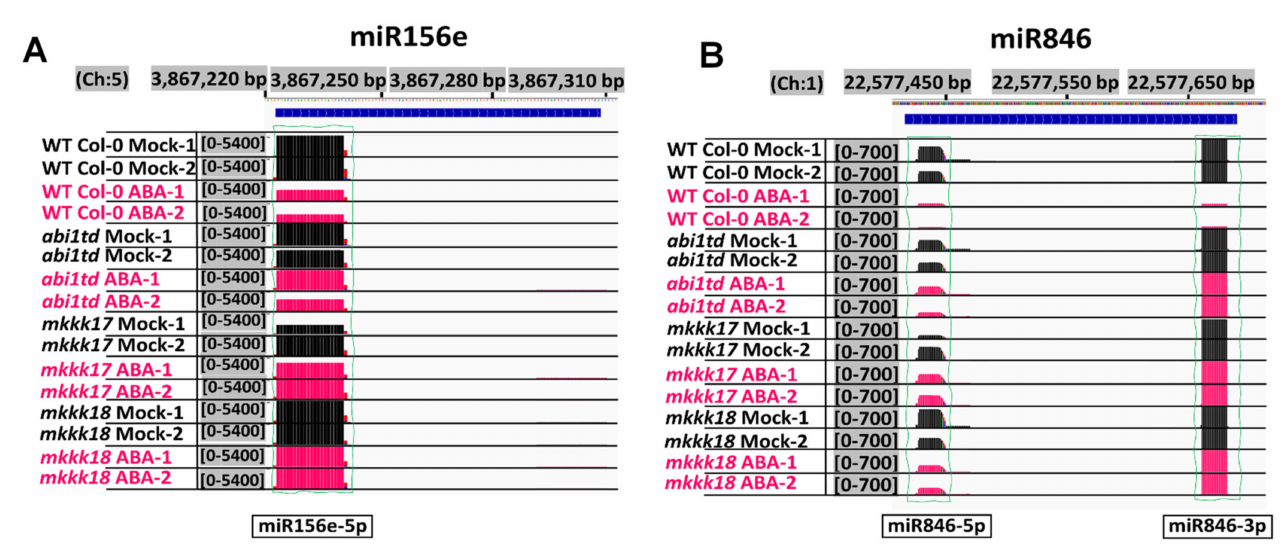
Figure 7. Expression profiles of the known miRNAs’ abundance in Arabidopsis WT Col-0, abi1td , mkkk17 , and mkkk18 mutants with or without ABA induction. These show the abundance of miRNAs ( A ) miR156e and ( B ) miR846 expressed in Arabidopsis WT Col-0, abi1td , mkkk17 , and mkkk18 mutants. Black bars indicate the number of aligned reads in mock samples and red bars indicate the number of aligned reads in 4 h of 100 µ M ABA-treated samples; therefore, coverage at the specific positions and abundance can be compared between genotypes after 4 h of ABA induction. Strong or weak expression can be observed for these miRNAs in all genotypes for the 3 (cid:48) , 5 (cid:48) -mature variants of these miRNAs. (Ch with numbers means chromosome